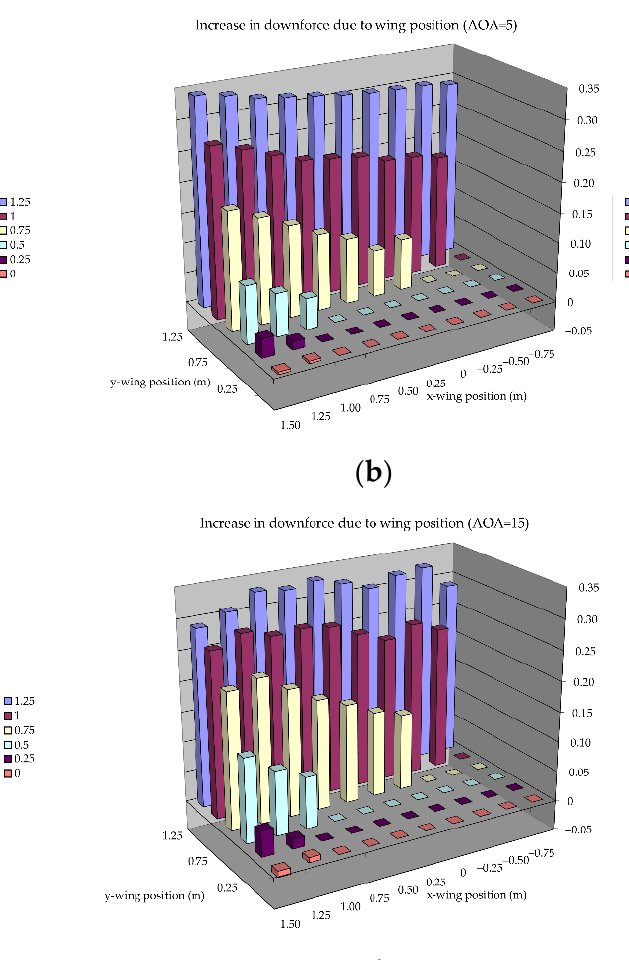
Figure 19. Increases in aerodynamic downforce coefficient as a function of the angle of attack and wing position in relation to the car body: ( a ) AOA 0 degrees; ( b ) AOA 5 degrees; ( c ) AOA 10 degrees; ( d ) AOA 15 degrees.